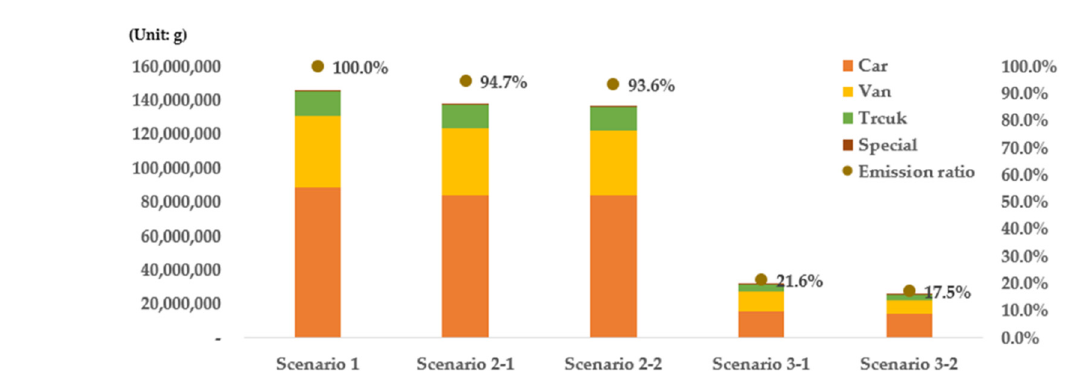
Figure 17. Vehicle emissions and emissions ratios by vehicle type. Table 4. Vehicle emissions and reduction efficiency by vehicle type.